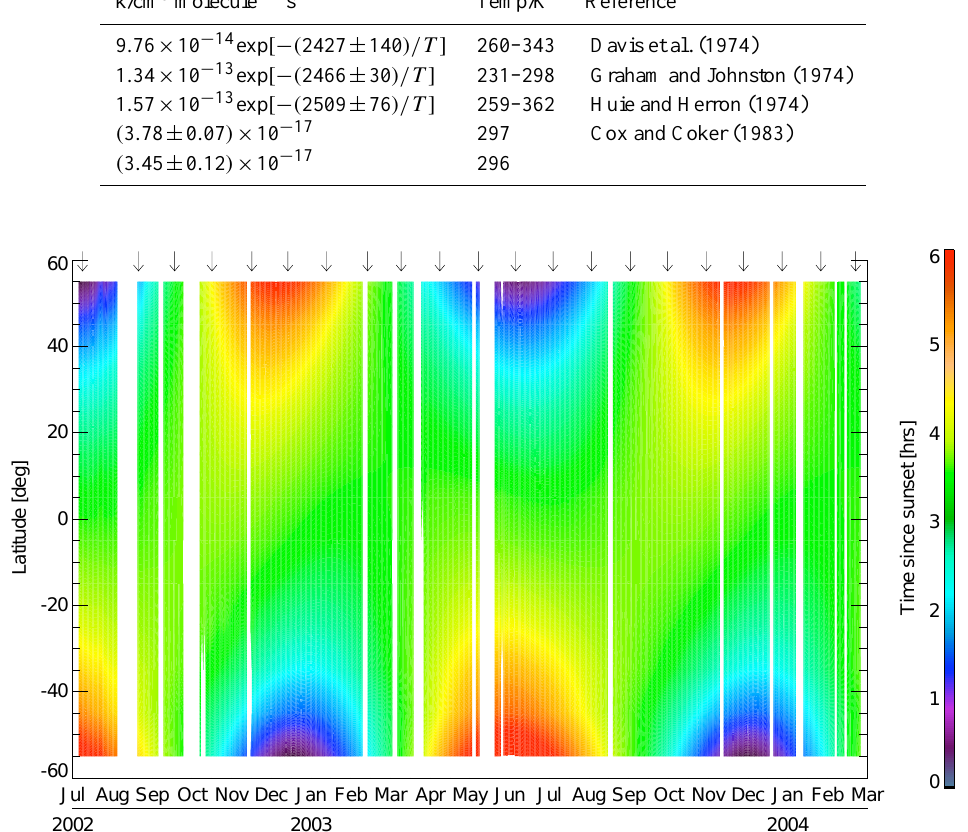
Fig. 2. Seasonal variation in time since sunset of MIPAS-ENVISAT nighttime observations. Arrows indicate sample days used to compute the reaction rate (9 July 2002, 23 August 2002, 21 September 2002, 21 October 2002, 22 November 2002, 21 December 2002, 21 Jan- uary 2003, 23 February 2003, 22 March 2003, 22 April 2003, 23 May 2003, 22 June 2003, 22 July 2003, 22 August 2003, 22 Septem- ber 2003, 22 October 2003, 22 November 2003, 22 December 2003, 22 January 2004, 22 February 2004, 22 March 2004). Red colours indicate summertime observations furthest from sunset. Blue colours indicate wintertime observations closest to sunset. White areas indicate where data was unavailable.